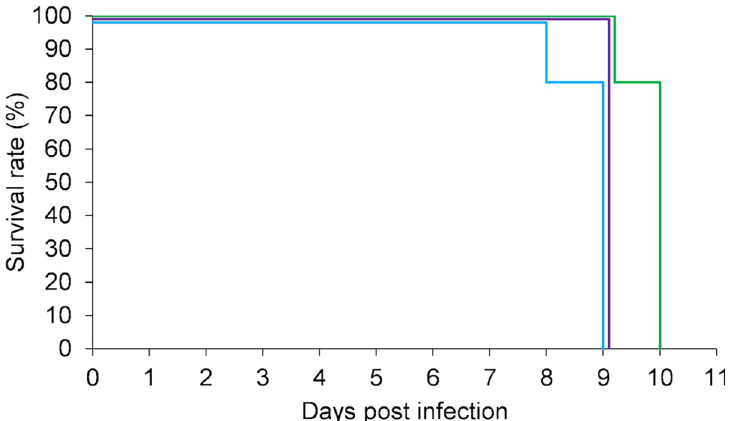
Fig 7. Pathogenicity of leptospires excreted in the urine of surviving hamsters in the chronic phase. Leptospires were isolated from 28 dpi urine of 3 surviving hamsters. Survival curves of hamsters subcutaneously infected with 1 × 10 4 cells of 3 isolates are shown (n = 5 in each group). Leptospires isolated from the urine of surviving hamsters had high pathogenicity.